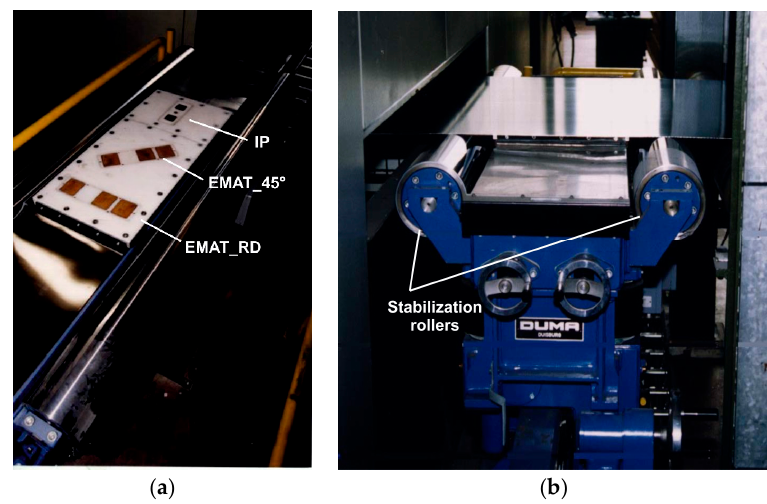
Figure 4. First prototype system for continuous testing of strength (Rp0.2) and deep-drawing (r m and ∆ r) parameters in strip steel based on a combination of the Incremental Permeability (IP) and the EMAT measuring technique: ( a ) Top view of the sensor, showing the IP sensor (IP) as well as the two EMAT sensors (EMAT_RD and EMAT_45°); and, ( b ) Complete table carrier with two stabilization rollers.